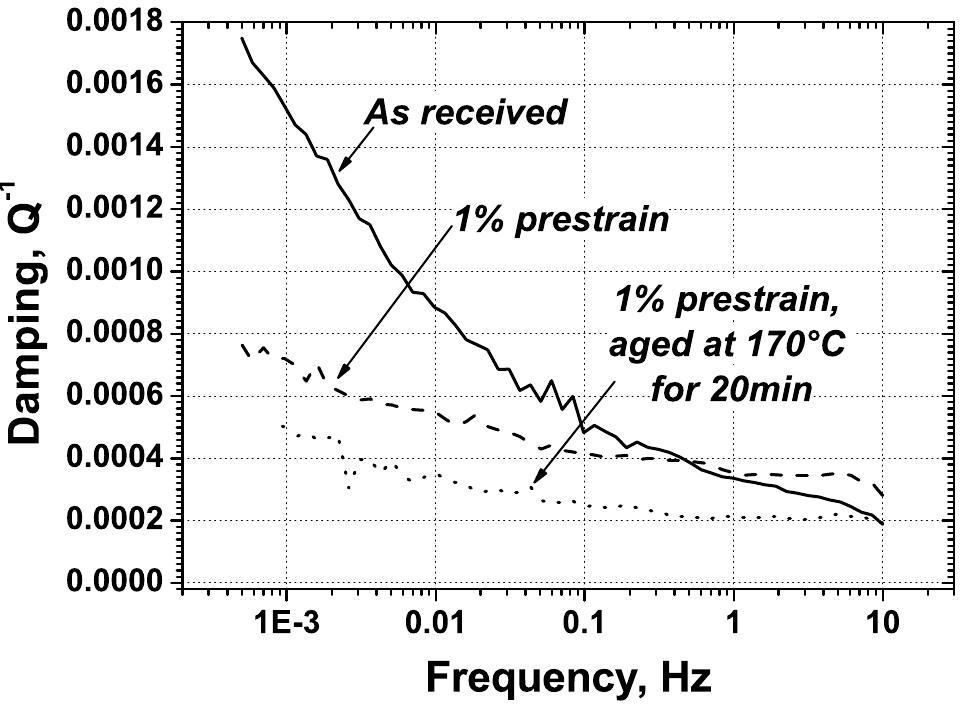
Figure 19. Internal friction measurement for the TRIP5 steel with 1 % prestrain and after aging at 170 ◦ C for 20